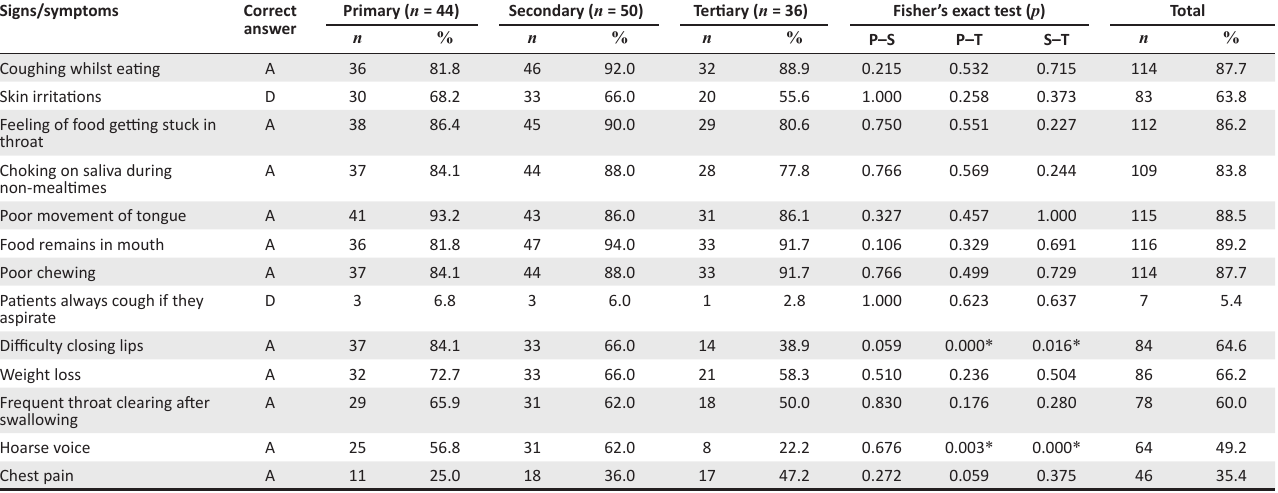
TABLE 2: Comparison of participants’ knowledge of signs and symptoms of oropharyngeal dysphagia ( N = 130).